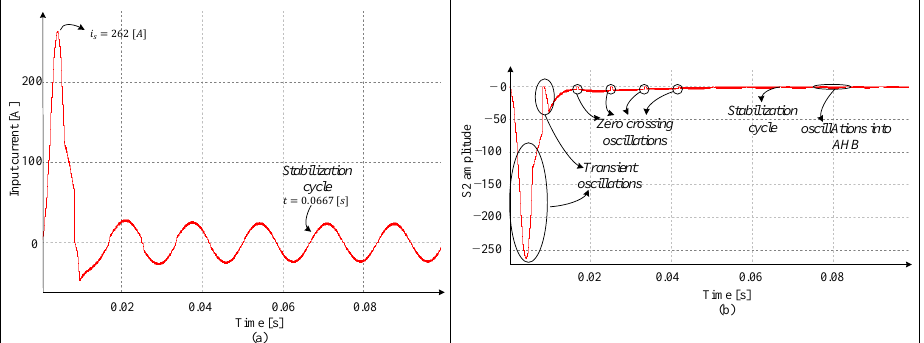
Figure 12. AC current behavior in start-up: ( a ) AC current; and ( b ) AC current error S 2 . The behavior of S 3 in start-up is presented in Figure 13. S 3 is reset each electric grid cycle to set the cumulative error as zero. S 3 begins in zero and immediately decreases near − 1.2 for the first peak; then, it increases again and reaches the convergence zone around S 3 = 0. S 3 provides robustness under disturbances; its effect is more evident during start-up reducing oscillations before reaching the steady state. To illustrate the impact of S 3 during start-up, Figure 14 shows the input current without using S 3 . Comparing Figures 12a and 14, it can be seen that current overshoot and stabilization time are reduced when S 3 is included in the sliding surface. The stabilization of DC voltage and AC current and the convergence to zero of their errors (including integral) in SBBC start-up demonstrate the stability of the proposed sliding surface outside the operation zone (hitting condition and Lyapunov